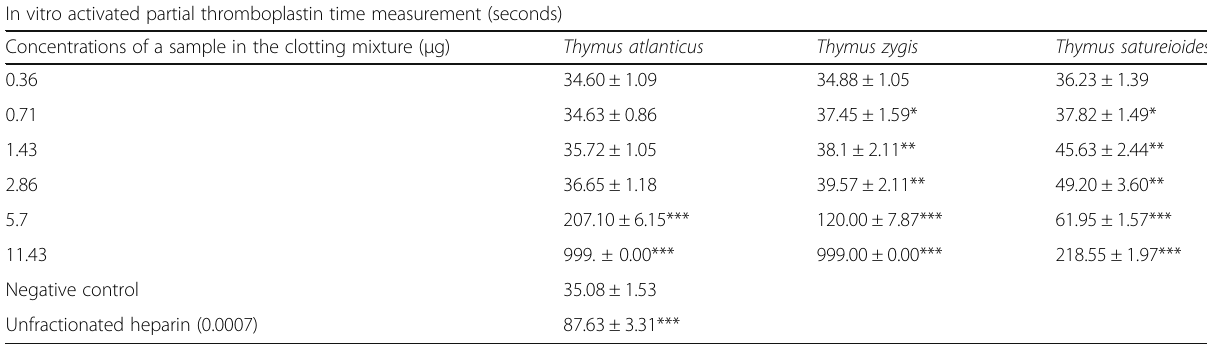
Table 3 In vitro activated partial thromboplastin time measurements of aqueous extracts in human pooled plasma In vitro activated partial thromboplastin time measurement (seconds) Concentrations of a sample in the clotting mixture ( μ g)